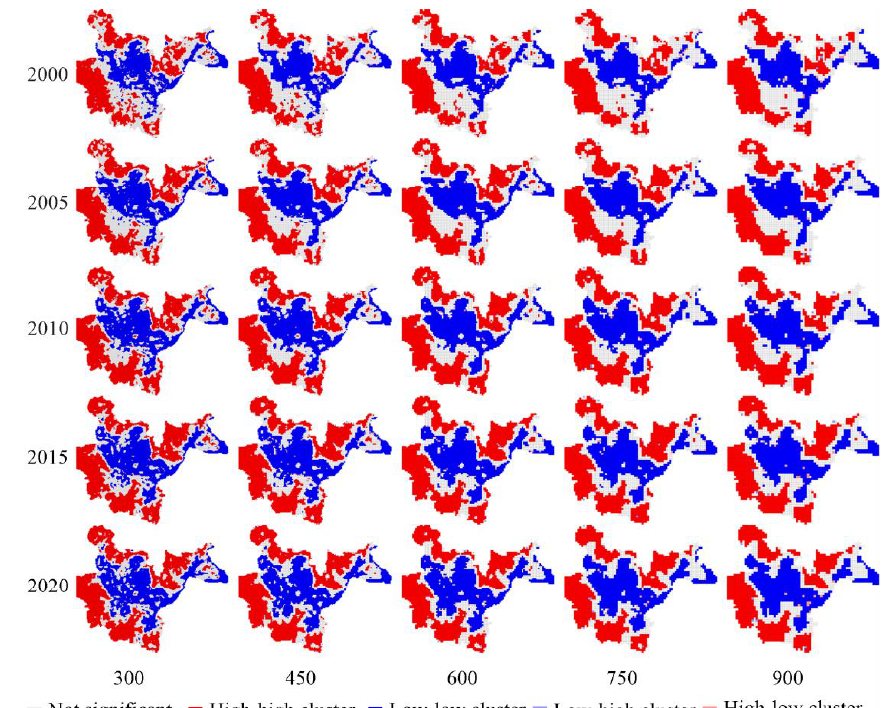
Figure 5. Fuzhou RSEI clustering map.